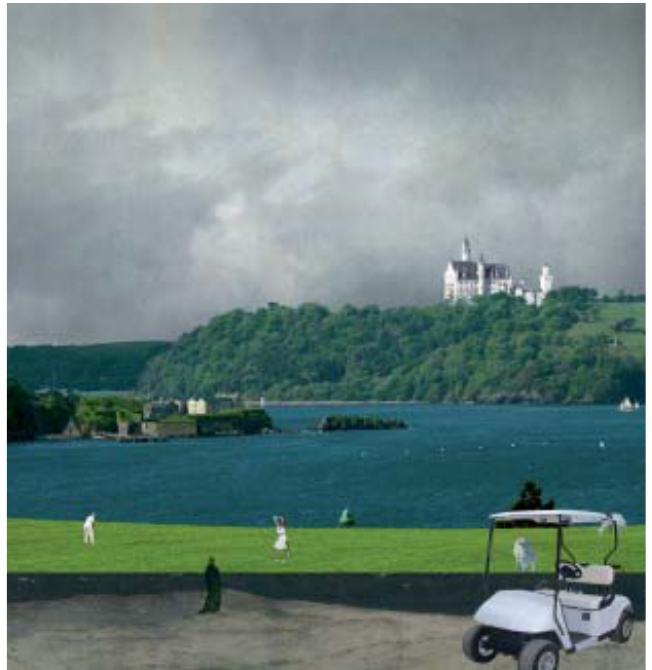
Figure 1. Future Landscapes: Collage “Historical Landscape” (Artner et al.